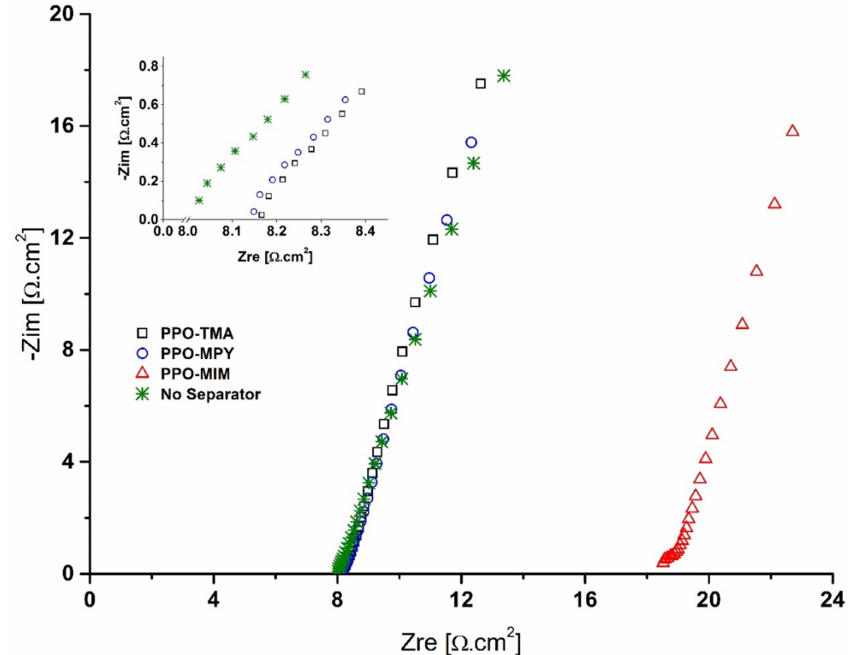
Figure 5. Nyquist plot of electrochemical impedance spectroscopy (EIS) for determining ionic conductivity of PPO-based separator